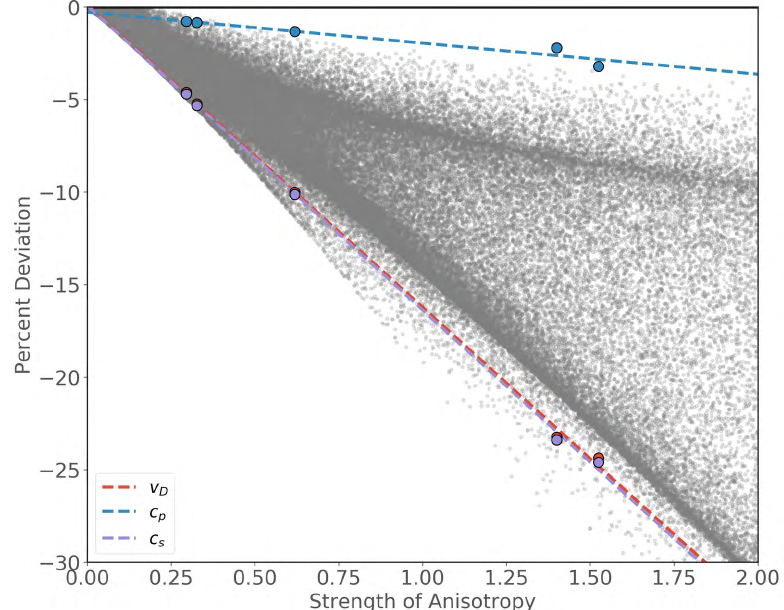
Figure 4. The dependence of the deviation of the Debye speed v D from that based upon the Voigt average, v V , and the seismic speeds for the hcp iron alloys in Table 1 as a function of the strength of D anisotropy A L . The semi-transparent grey circles represent the difference between v D (Equation (7)) and v V (Equation (3)) for 10 6 randomly generated transversely isotropic elastic tensors with the same D seismic wave speeds as those of pure iron (Table 1). The red circles correspond to the difference between v D and v V for the five hcp iron alloys (Table 1) and the blue and purple circles denote the D corresponding deviation in inferred acoustic longitudinal and transverse wave speeds, respectively (Table 3). The dashed lines represent linear best fits to the acoustic wave speed